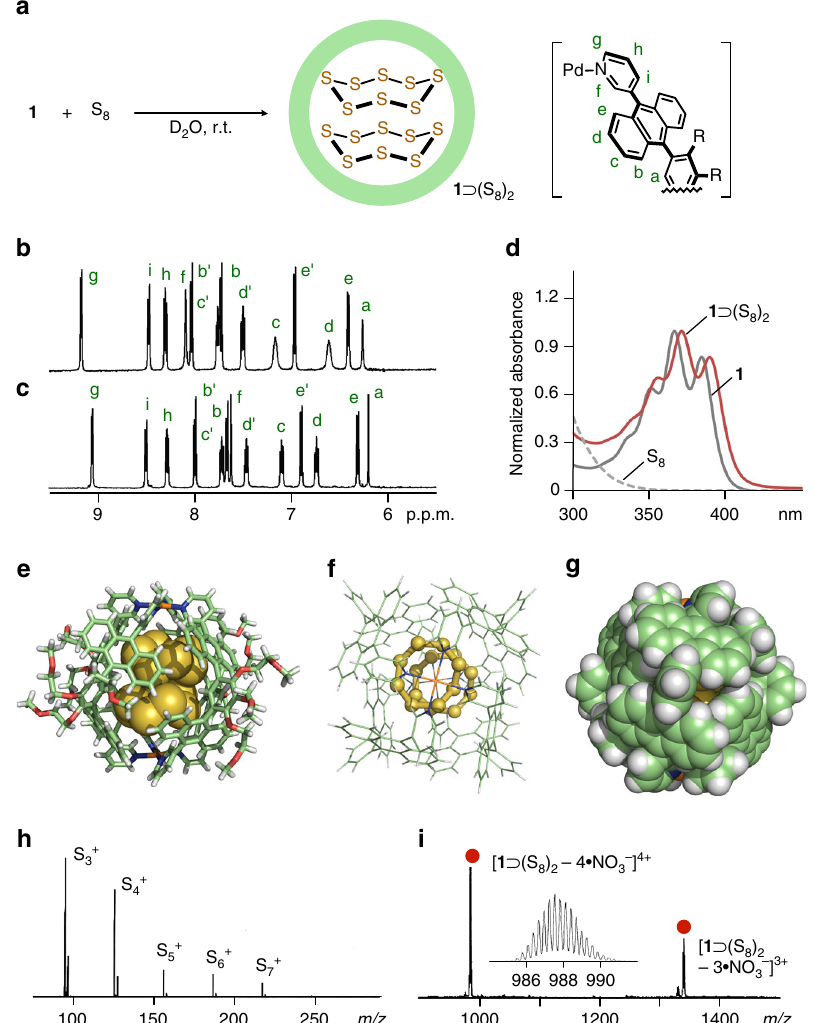
Fig. 2 Formation and characterization of 1 ⊃ (S 8 ) 2 . a Schematic representation of the encapsulation of two S 8 clusters within matrix 1 . 1 H NMR spectra (500 MHz, D 2 O, room temperature) of b 1 and c 1 ⊃ (S 8 ) 2 . d UV-visible spectra (room temperature) of 1 and 1 ⊃ (S 8 ) 2 in H 2 O, and S 8 in CH 3 OH. X-ray crystal structure of 1 ⊃ (S 8 ) 2 (host and guest parts): e cylinder and space- fi lling representation, f ball-and-stick, and g space- fi lling representations (the peripheral substituents are replaced by hydrogen atoms). h MALDI-TOF MS spectrum of S 8 . i ESI-TOF MS spectrum (H 2 O) of 1 ⊃ (S 8 ) 2 and the expansion of the [ 1 ⊃ (S 8 ) 2 − 4 (cid:129) NO 3 − ] 4+